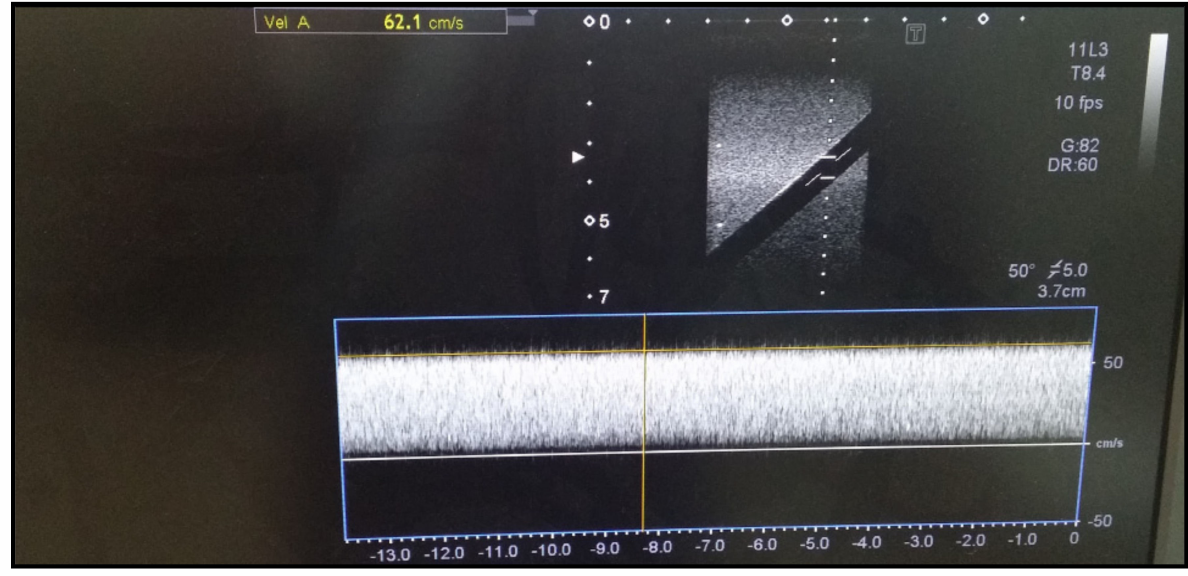
Figure 7. Blood flow